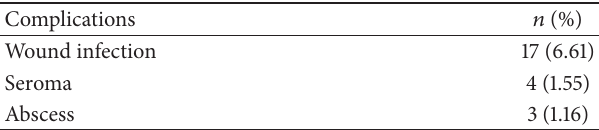
Table 2: Postoperative